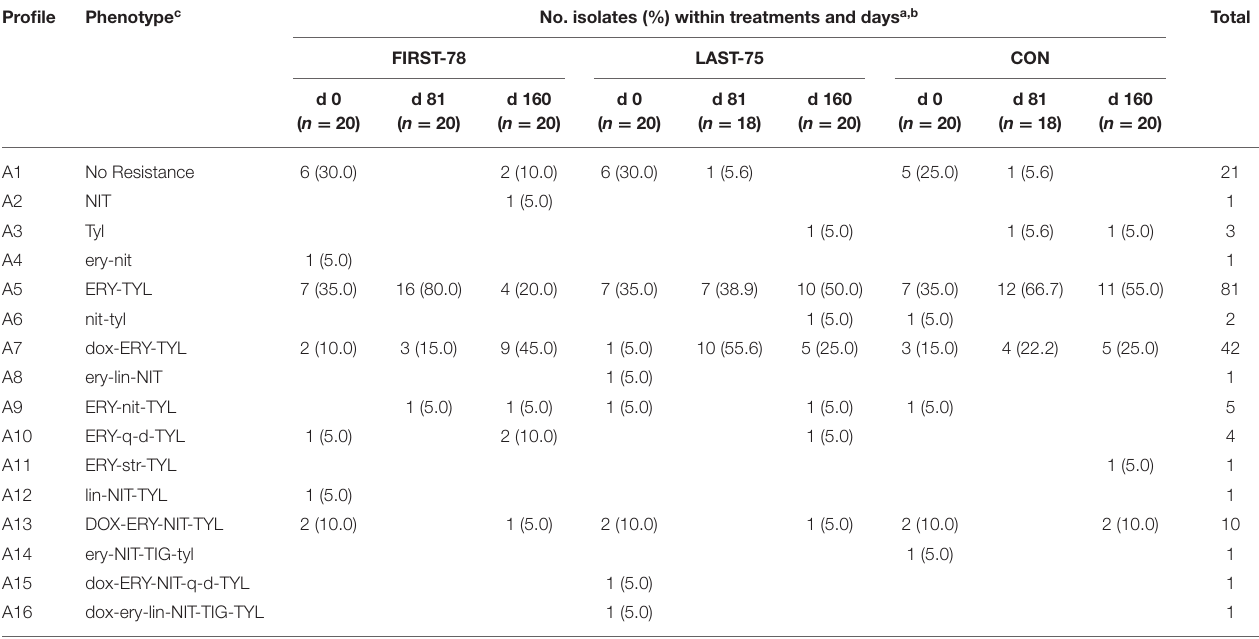
TABLE 2 | Antibiograms of enterococci ( n = 176) isolated from feedlot cattle feces from cattle fed tylosin for the FIRST-78% , LAST-75% , or continuously ( CON ) during the feeding period. Profile